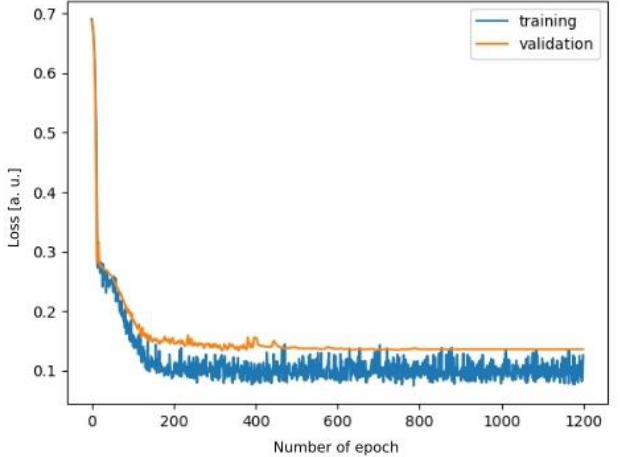
Figure 8. A plot representing the training process (loss function depending on the number of epochs).